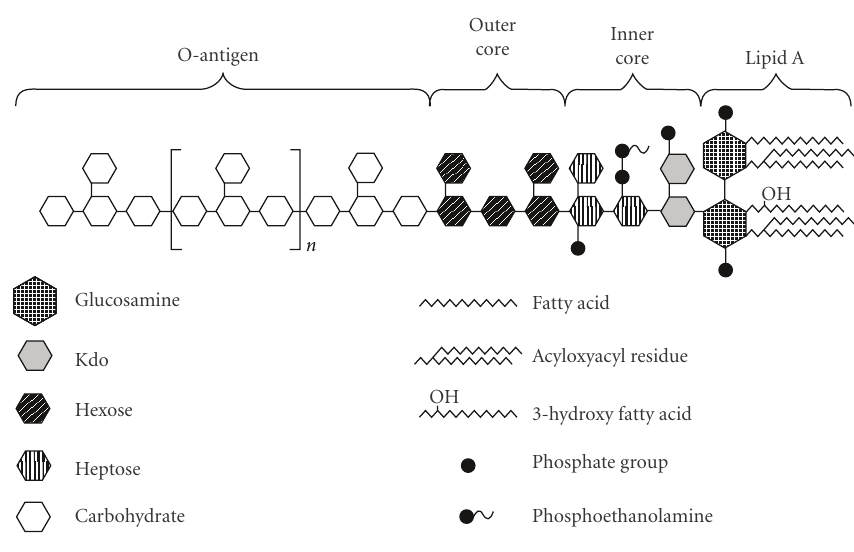
Figure 1: The structure of bacterial